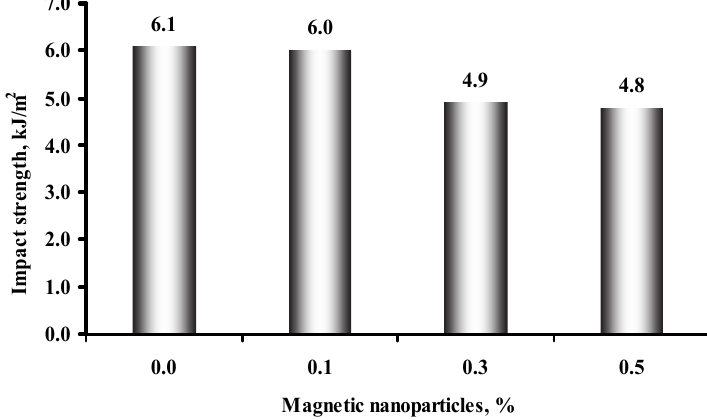
Figure 6: Impact strength of magnetic composites with different content of magnetic nanoparticles.